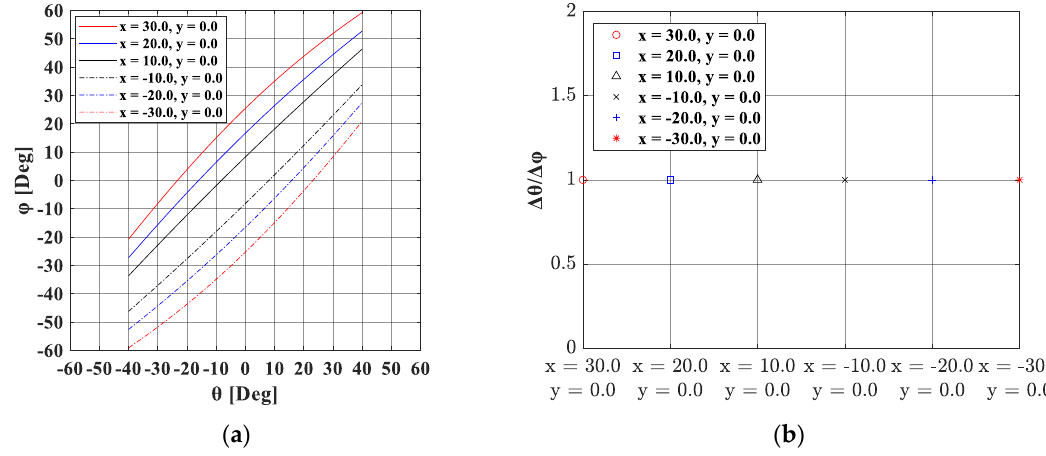
Figure 13. ( a ) Relationship of θ and ϕ with the x o ff set; ( b ) comparison of θ and ϕ with the x o ff Figure 13. ( a ) Relationship of θ and φ with the x offset; ( b ) c omparison of θ and φ with the x offset. Figure 13. ( a ) Relationship of θ and φ with the x offset; ( b ) c omparison of θ and φ with the x offset. Figure 13. ( a ) Relationship of θ and φ with the x offset; ( b ) c omparison of θ and φ with the x offset.